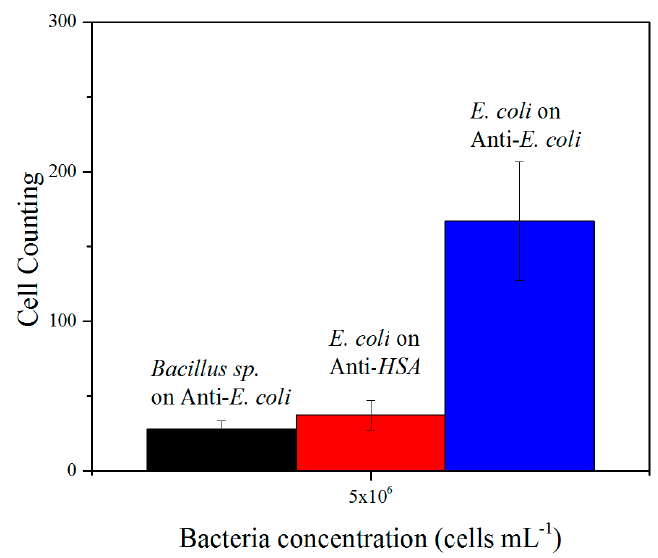
Figure 5. Comparison of bacteria binding, in counts, to different antibodies at a concentration of 10 6 cells mL − 1 . E. coli bacteria were tested against anti- E. coli (positive control for specificity) and anti-HSA (negative control for specificity). A second negative control was performed using Bacillus sp. bacteria against anti- E. coli .